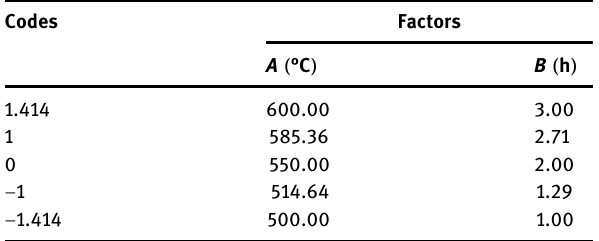
Table 2: Experimental factors and codes used in CCD Codes